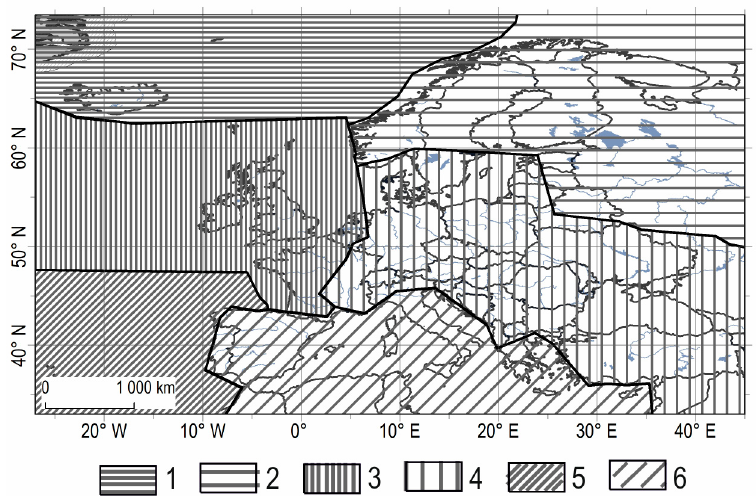
Figure 5. Humidity regions in Europe (1981–2015). Table 1. Moisture characteristics for selected European humidity regions (explanation in the text).